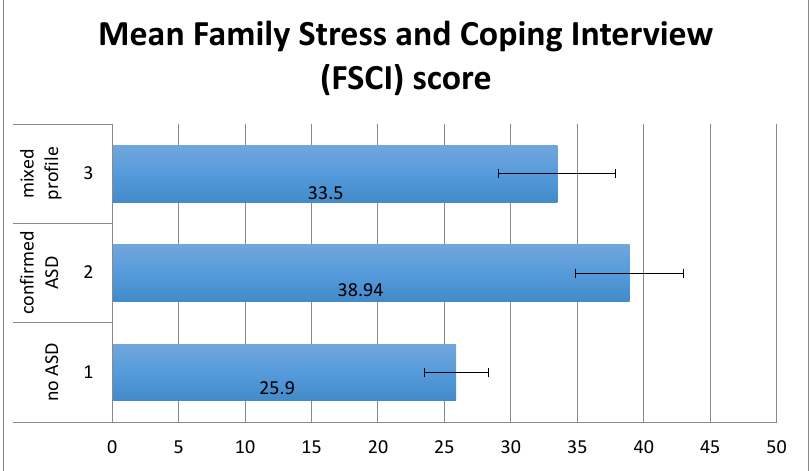
Figure 2. Mean FSCI scores by group. Error bars show ±1 standard error.